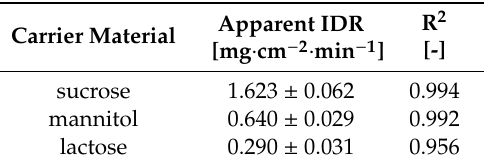
Table 5. Apparent intrinsic dissolution rates (IDRs), corresponding standard deviations and R 2 of linear fits of intrinsic dissolution data determined according to Ph. Eur. 2.9.29 (with modifications) for the different carrier materials ( n = 3).